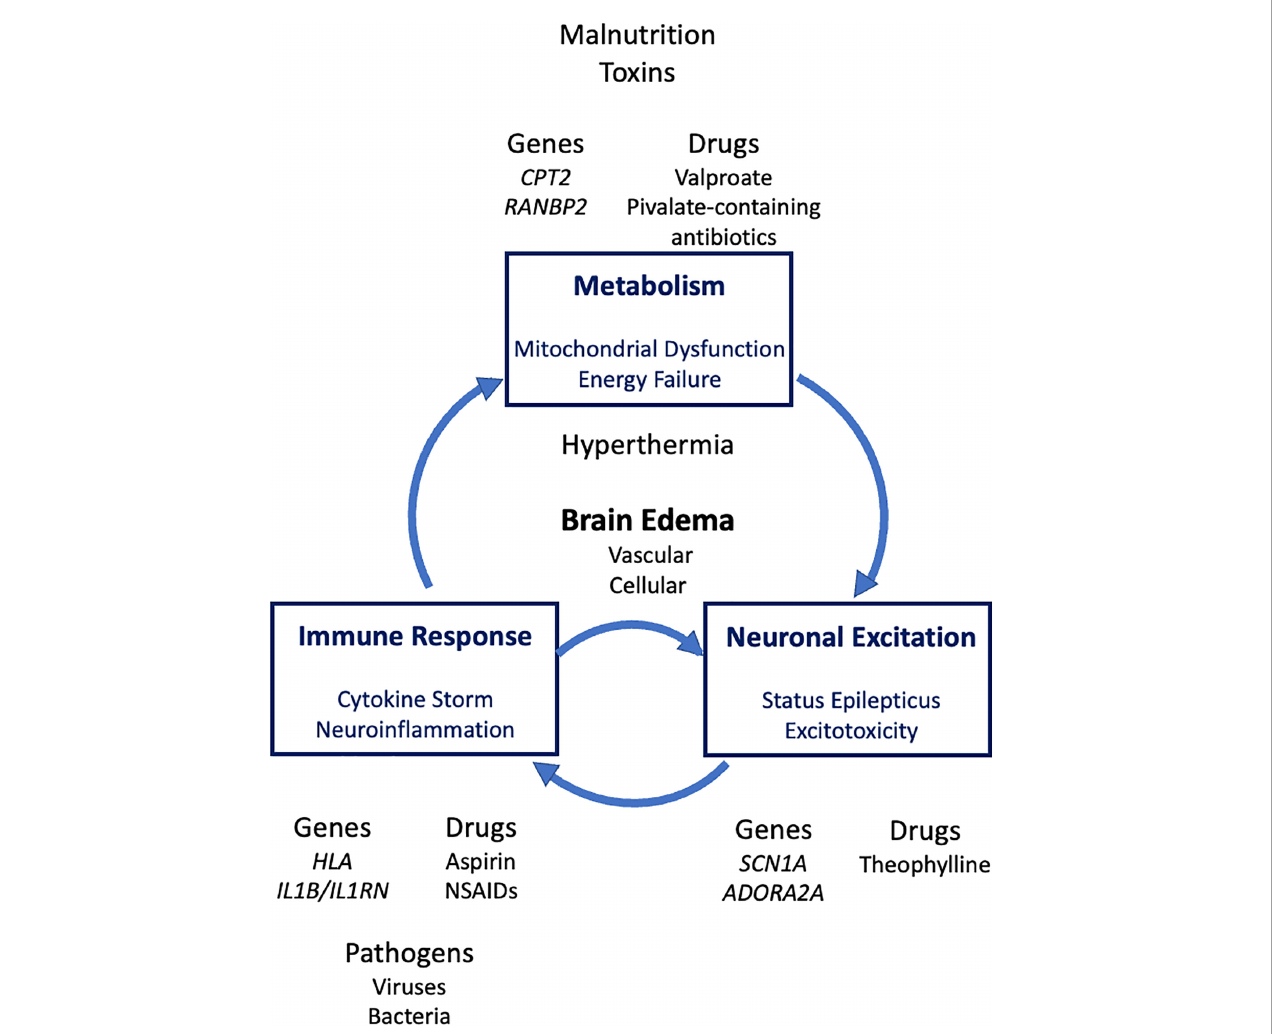
FIGURE2 Genetic and environmental risk factors and major pathologic processes of severe acute encephalopathy. HLA, human leukocyte antigen; NSAIDs, non-steroidal anti-inflammatory drugs.